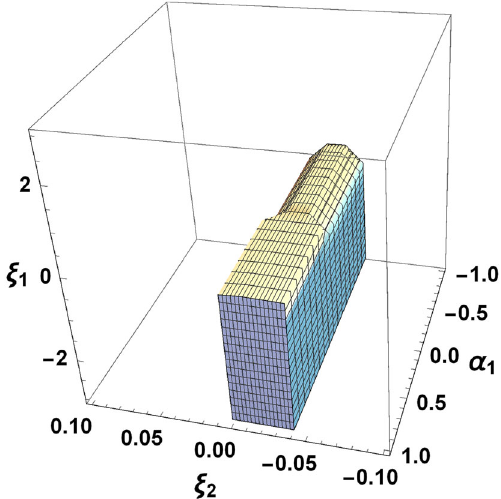
Fig. 10 The non-exclusive saddle regions where the P 9 critical point represents a saddle cosmological epoch ( z 2 = 0 ,α 2 = 1 , E P [ 2 ] < 0 ,w = 0 , E P m 9